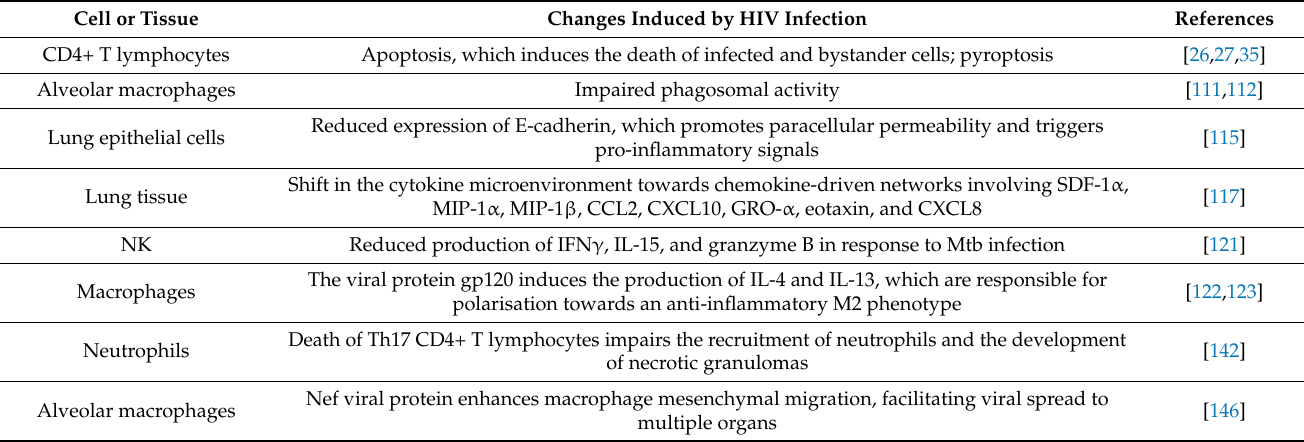
Table 1. HIV-induced changes in various cells and tissues that directly affect the immune response to Mtb.